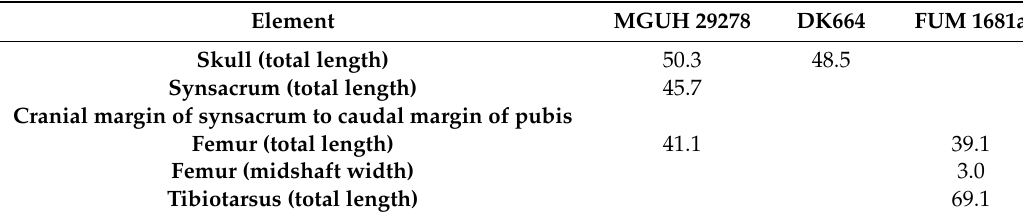
Table 2. Selected measurements (right / left, in mm) of the holotype specimen, MGUH 29278, and two